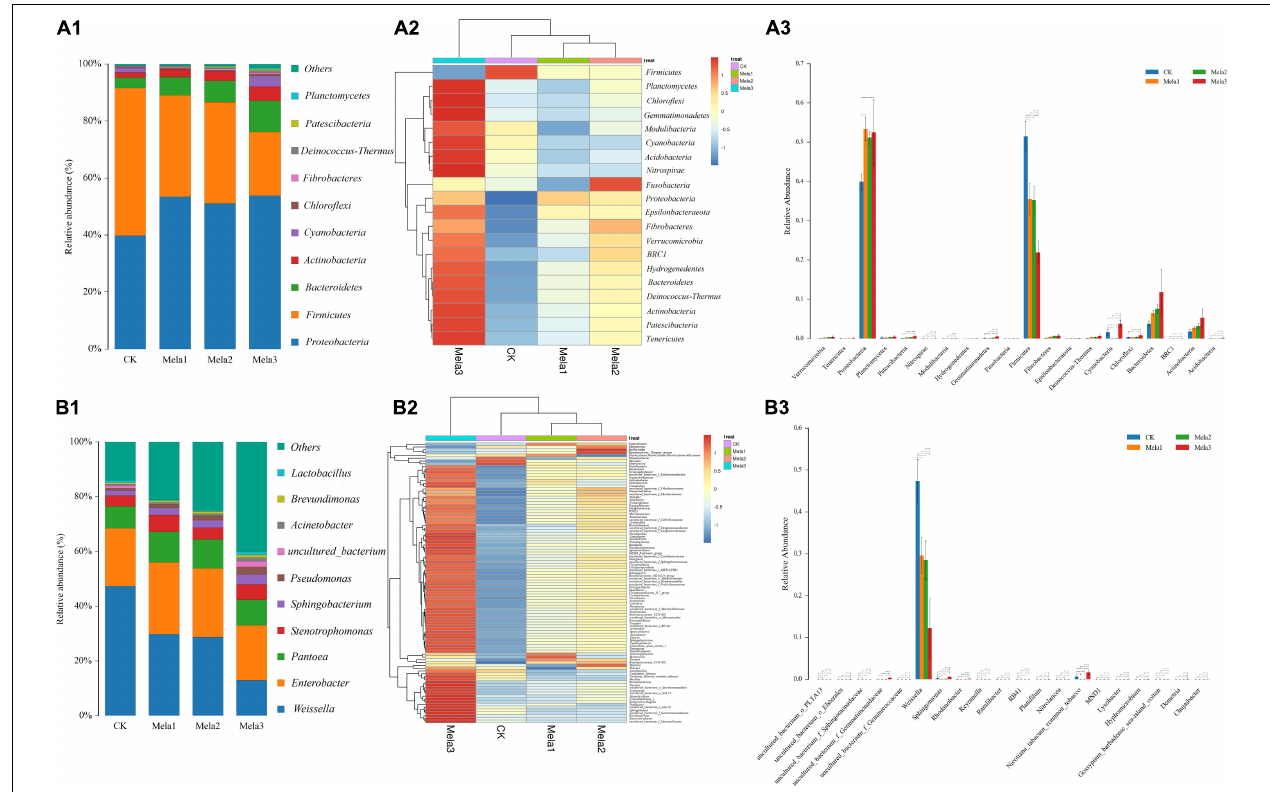
( Figure 6E ). The monobactam biosynthesis, sulfur metabolism, purine metabolism, cysteine and methionine metabolism and ABC transporters were also altered between the CK and Mela3 groups ( Figure 6F ). Collectively, melatonin addition significantly altered the metabolism of silage